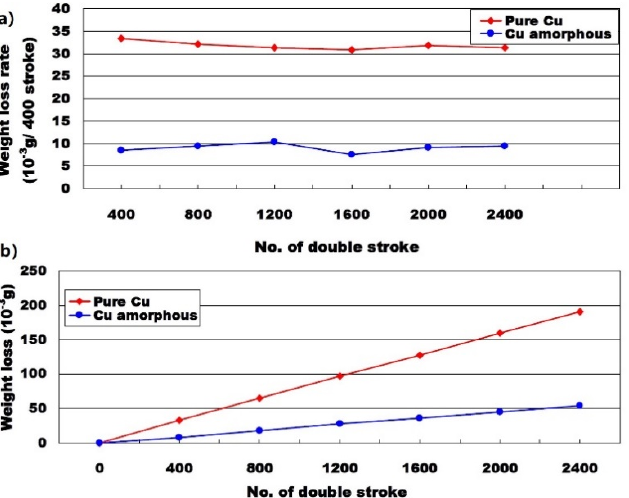
Figure 8. Wear performance of the pure Cu and Cu-based amorphous coatings; ( a ) weight loss rate and ( b ) weight loss [62] .